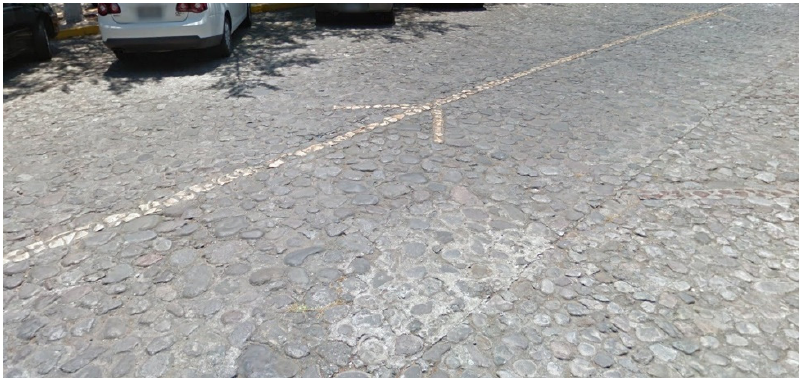
Figure 5. Roughness detail of “Cobblestone” Zone.